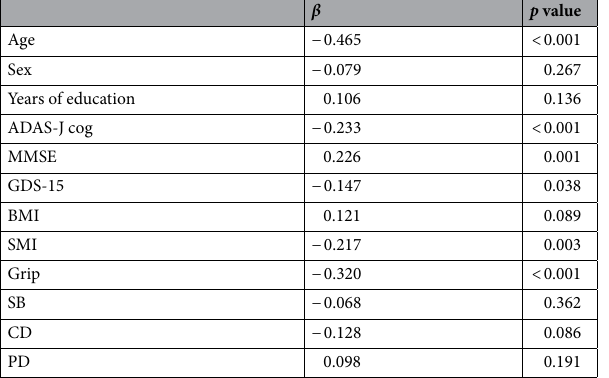
Table 5. Univariate regression analysis for normal gait speed. Cut-off point for GDS-15 was 5/6. Cut-off point for handgrip strength of < 28 kg for men and < 18 kg for women; cut-off for low SMI was < 7.0 kg/m 2 in men and < 5.7 kg/m 2 in women. ADAS Alzheimer’s disease assessment scale, MMSE mini mental state